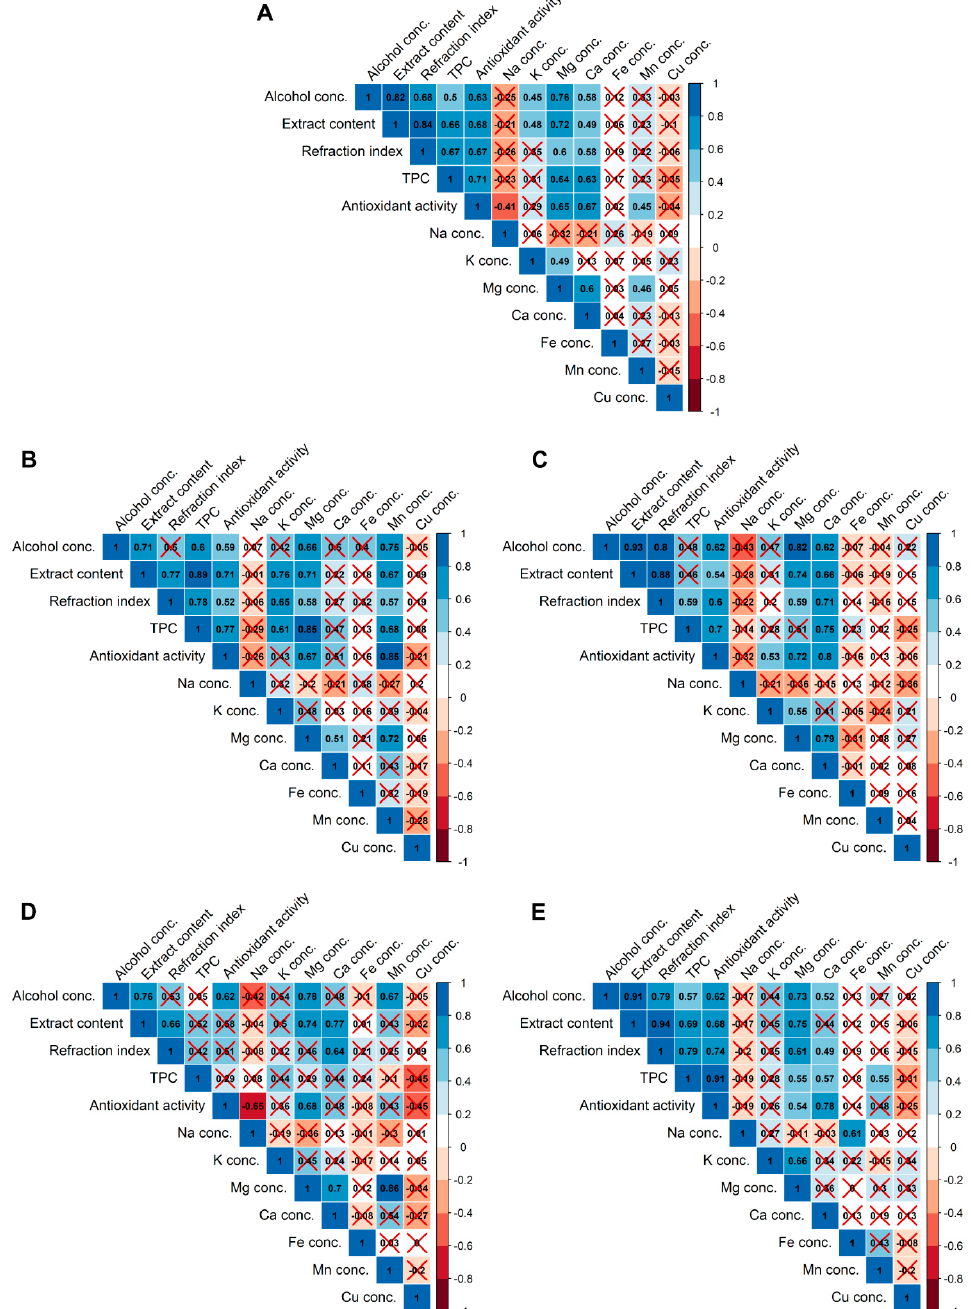
Figure 1. Correlation heatmap for unfiltered beer parameters ( A ; n = 29), pale ( B ; n = 15), dark ( C ; n = 14), top-fermented ( D ; n = 12), and bottom-fermented ( E ; n = 17) beers. The colored and labeled scale codes are for the value of the Spearman’s rank correlation coefficient r s . Positive correlations are blue, while negative correlations are red. However, red crosses show insignificant correlations ( p ≥ 0.05). Factor maps for the first three dimensions (principal components) obtained from FAMD, representing individuals (different beers) and different categories (qualitative and quantitative